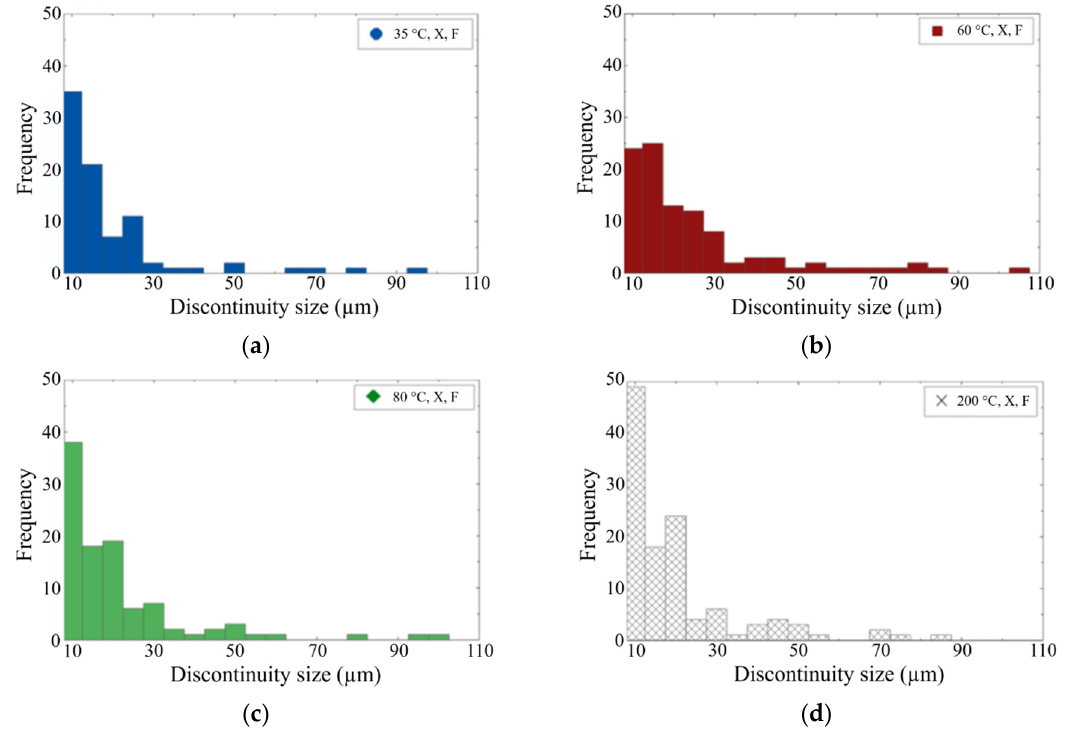
Figure 7. Histograms of porosity size of AlSi7Mg X as-built parts produced by SLM at 35 °C ( a ), 60 °C ( b ) 80 °C ( c ) and 200 °C ( d ).